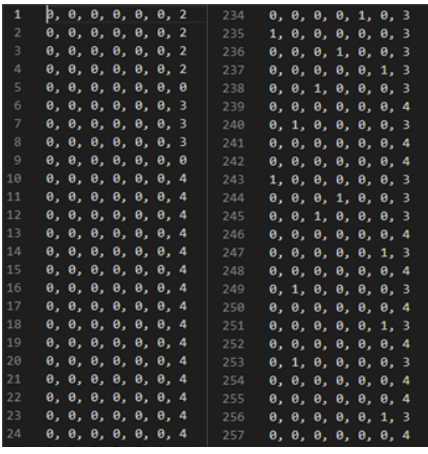
Figure 5. The actual composition of the CSV